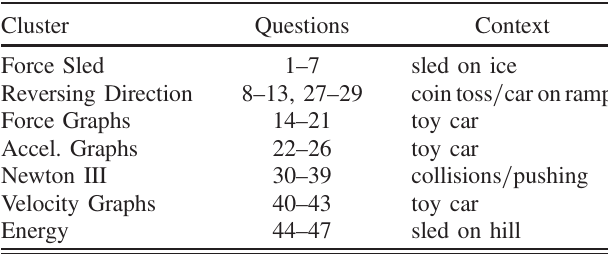
TABLE I. Question clusters on the FMCE [11].